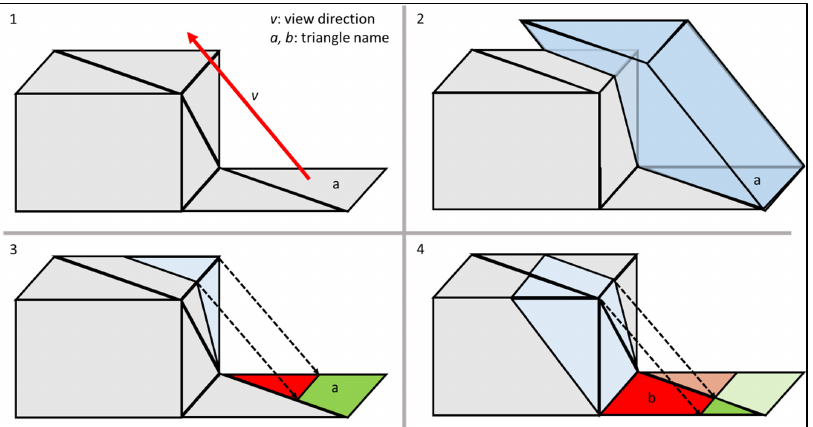
Figure 6. Working principle to verify the reachability of a triangle of the STL model. ( 1 ) The triangle and the corresponding view direction are selected. ( 2 ) Determination of the view space. ( 3 ) Determination of reachable surface. ( 4 ) Repetition of the process for the next triangle.